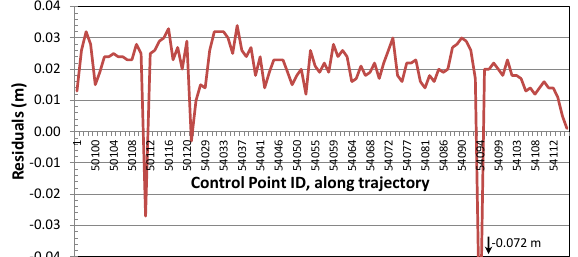
Figure 12. Comparison of residuals of control polyline to initial control point coordinates